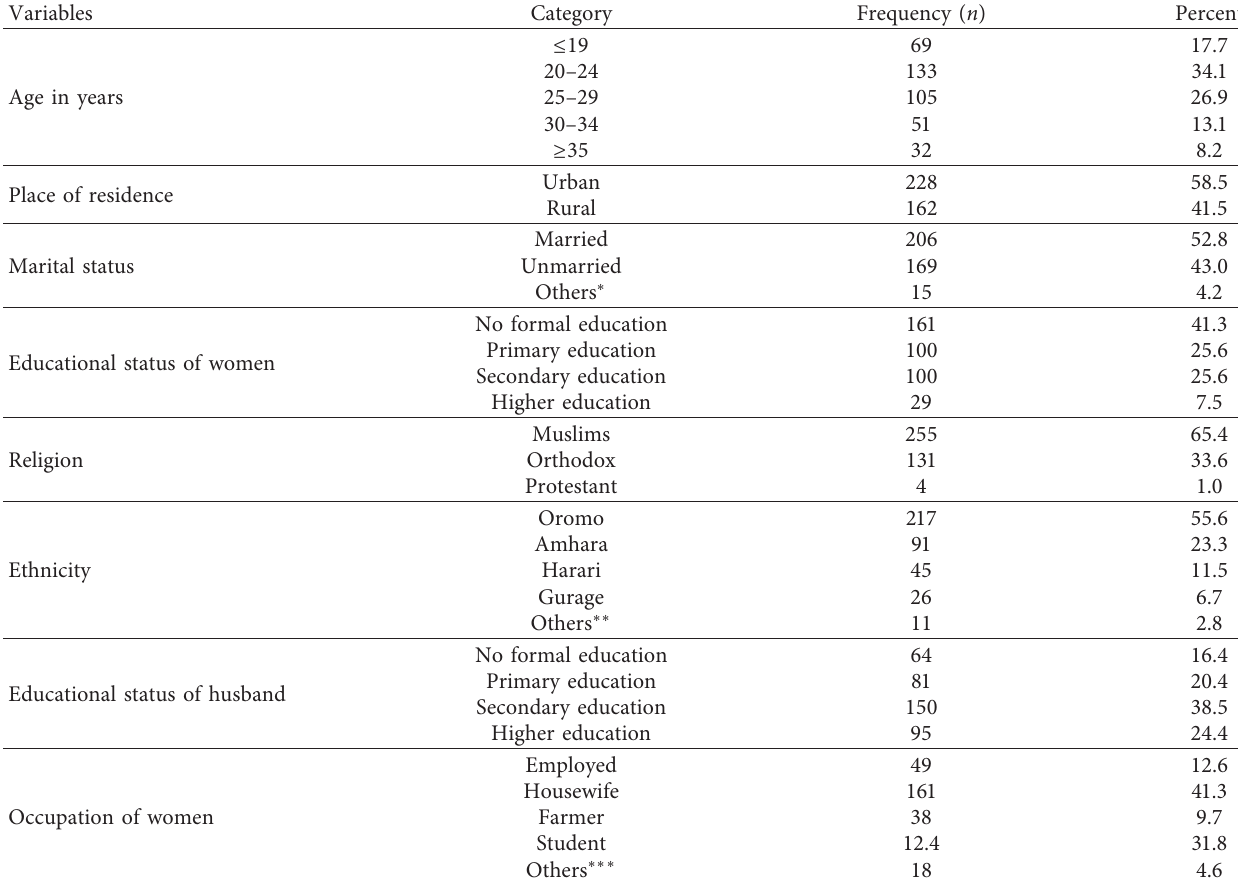
Table 1: Socioeconomic and demographic characteristics of study participants in Harar Town health facility, Eastern Ethiopia ( N � 390).